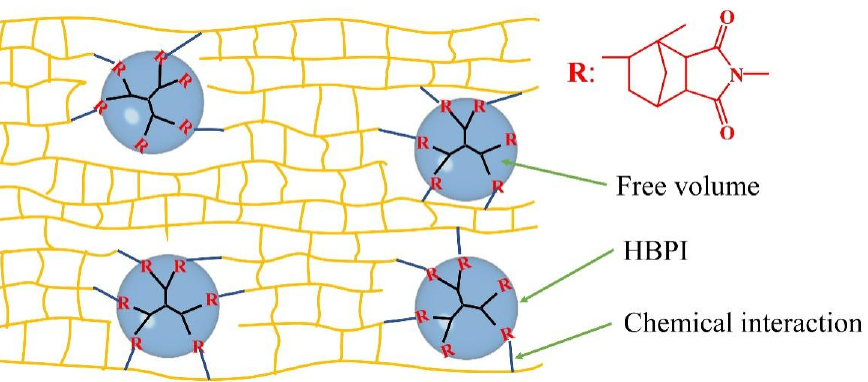
Figure 1. Cured network structure of HBPI modified BMI.